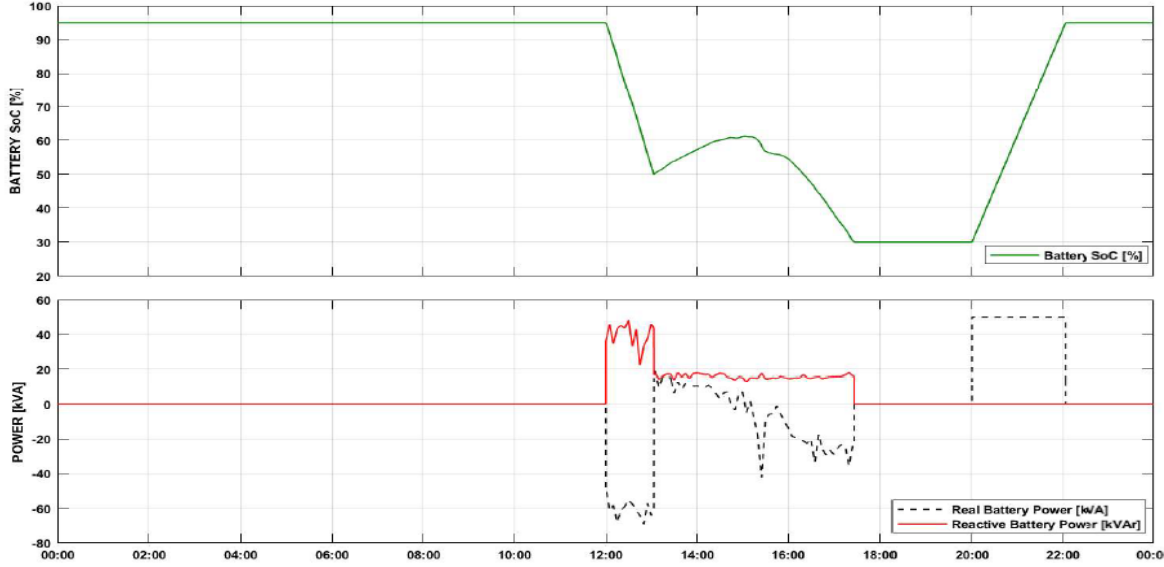
Figure 23. Performance of the optimum-sized energy storage during an 8-h power cut at 12 p.m.